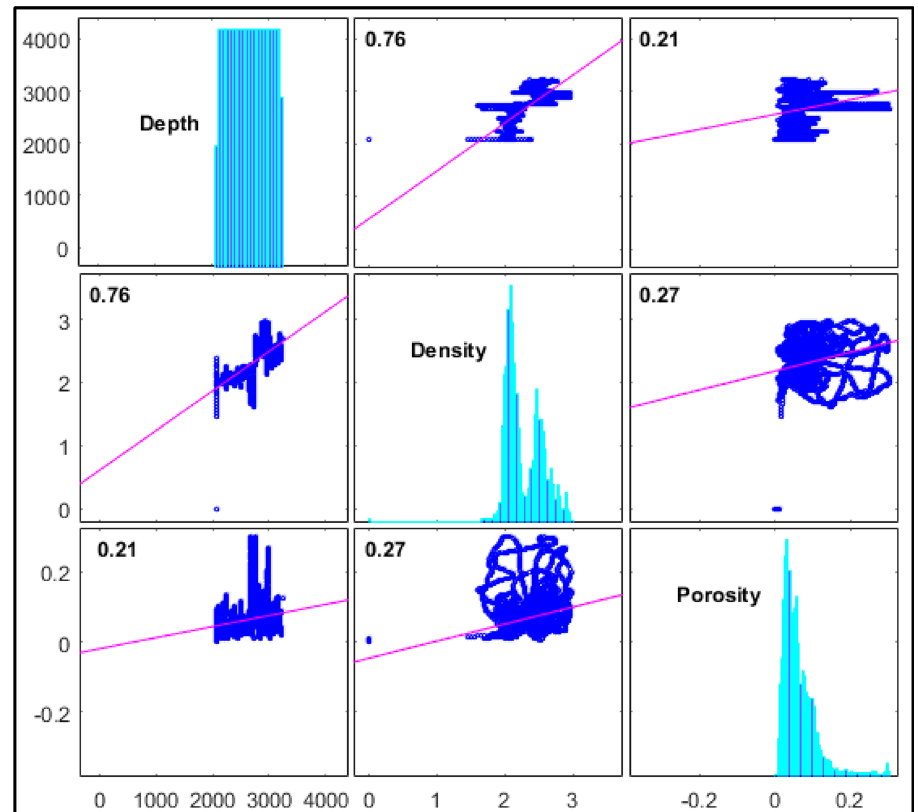
Fig. 8 Correlation matrix of well-1 among depth, density, and porosity with diagonal histogram and correlation coef-